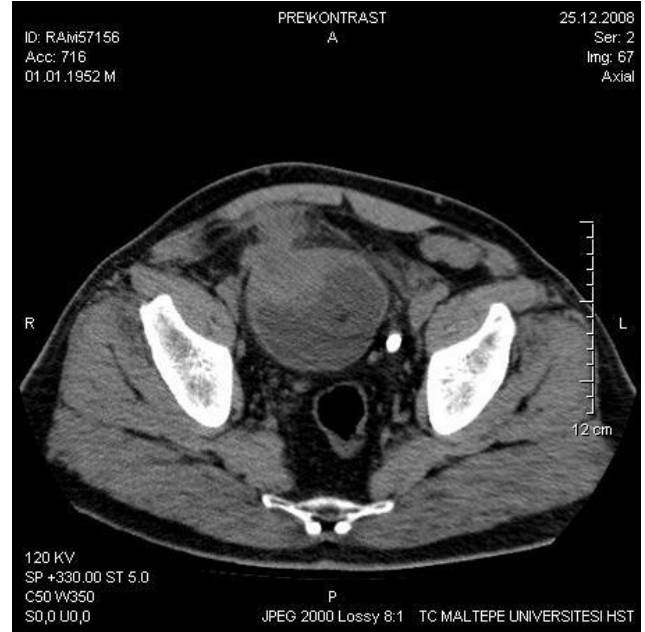
FIGURE 1. CT image without contrast; solid lesion (60  55 mm) with central necrosis in the right side of the anterolateral wall of the bladder was detected. The mass was presented with local perivesical invasion at the anterolateral side of the urinary bladder.